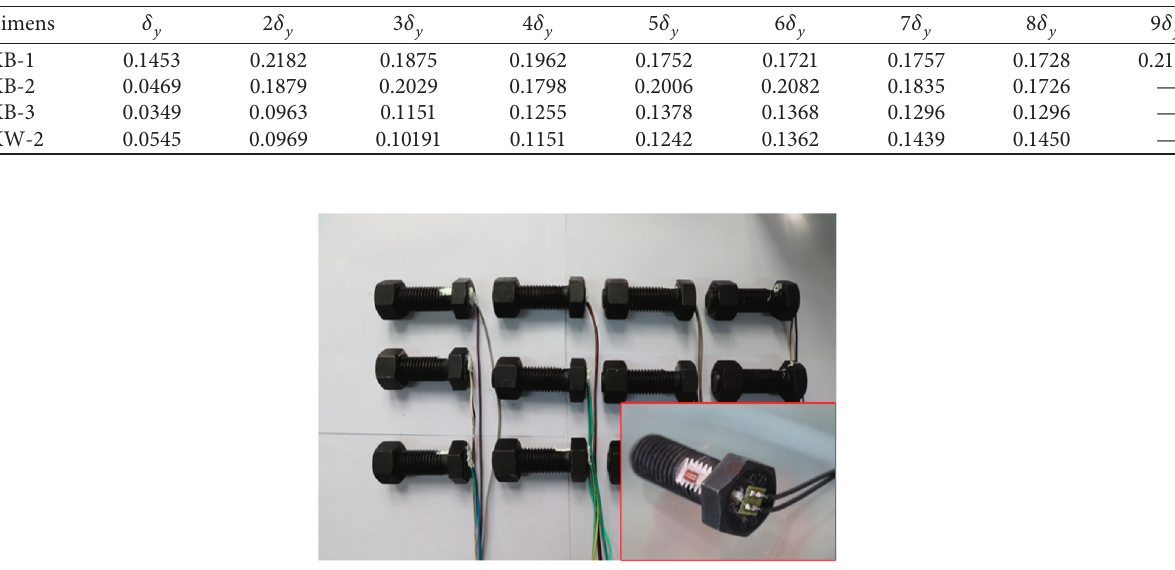
Table 13: Equivalent damping coefficients of the specimens.